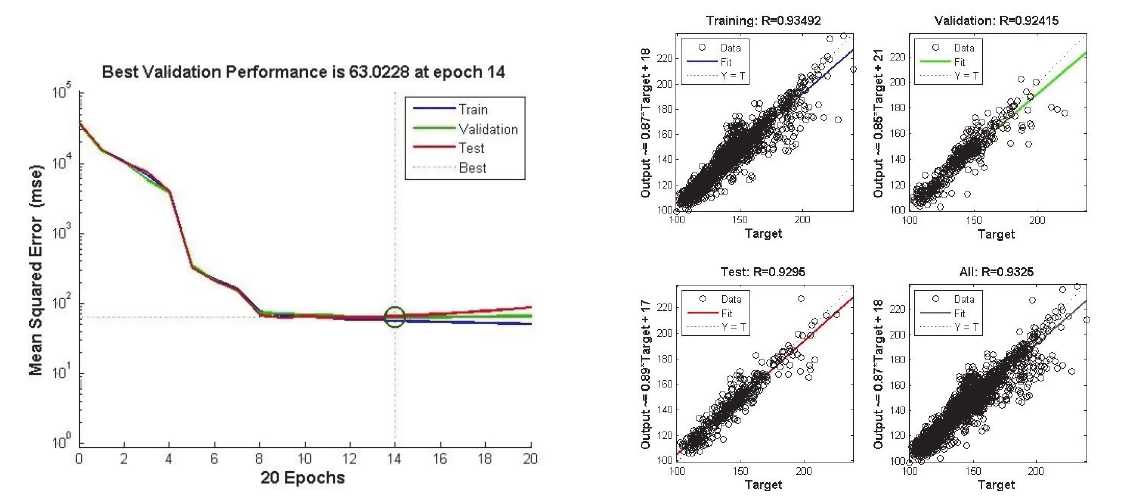
Fig. 6. performance of MCS model Fig. 7. Regression diagrams of MCS model